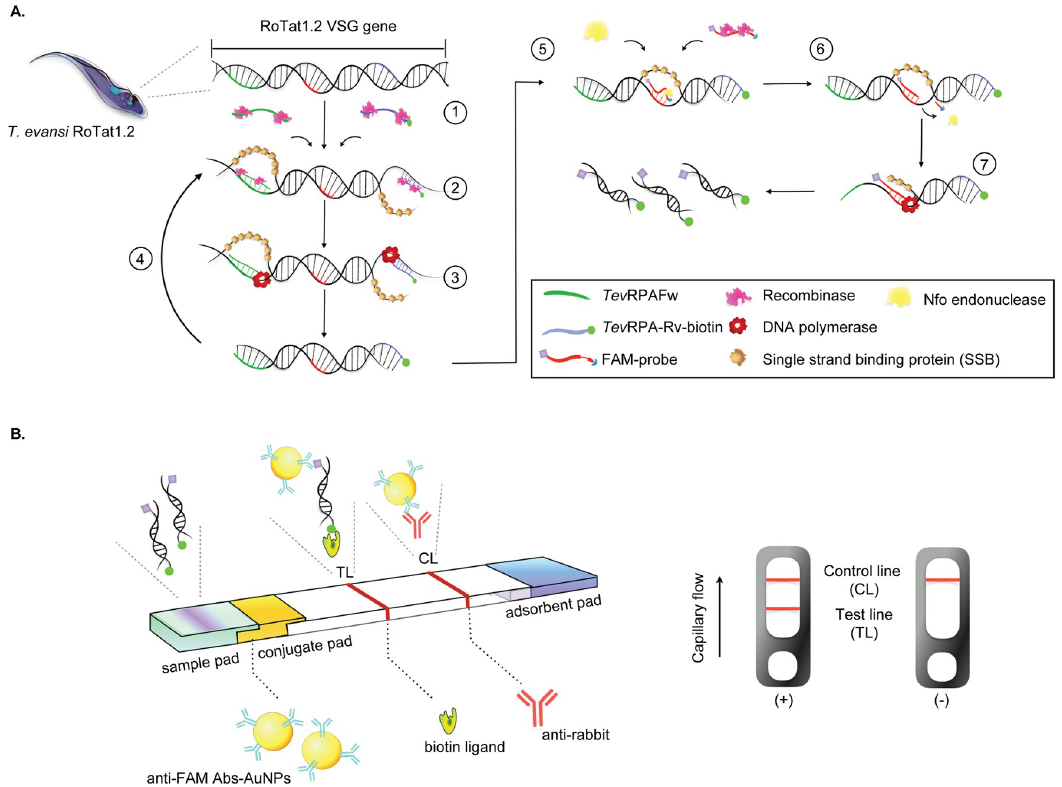
Fig 1. Schematic representation of the Tev RPA-LF. A: RPA-based generation of a T. evansi specific RoTat1.2 VSG amplicon for detection by a lateral flow (LF) assay. Step 1: two oligonucleotide primers ( Tev RPA-Fw and Tev RPA-Rv-biotin) form a complex with the recombinase. Step 2: the primer-recombinase complexes invade the homologous sequences on the target DNA. Step 3: A DNA polymerase with a strand displacement activity performs amplification of the target sequence under isothermal conditions, resulting in the generation of a biotinylated amplicon. Step 4: the generated amplicons are again invaded by primer-recombinase complexes in a self-perpetuating cycle fueled in ATP by creatine kinase. Step 5: an oligonucleotide (FAM-probe) carrying a 5’ FAM tag, a spacer sequence and a 3’ blocking group forms a complex with the recombinase and invades the biotinylated amplicon generated in the previous steps. Step 6: only when the FAM-probe has successfully invaded the biotinylated amplicon and bound its complementary sequence, can the Nfo endonuclease bind and cleave the spacer region and 3’ blocking group. Step 7: after removal of the 3’ region of the FAM probe, the Nfo endonuclease dissociates. This allows the DNA polymerase to employ the cleaved FAM-probe as a forward primer. Together with the biotinylated reverse primer ( Tev RPA-Rv-biotin) this leads to the formation of an amplicon bearing both the FAM and biotin tags. B: Read-out of the RPA via LF. The FAM- and biotin-tagged RPA product is mixed with the LF buffer, loaded onto the sample pad and is transported to the adsorbent pad through capillary flow. The RPA product is first bound by gold- labeled rabbit anti-FAM antibodies and later captured by a streptavidin-coated test line (TL). The control line (CL) is coated with anti-rabbit antibodies. While a valid negative test only contains a reddish band at the CL, a valid positive test will display bands at both the TL and CL.